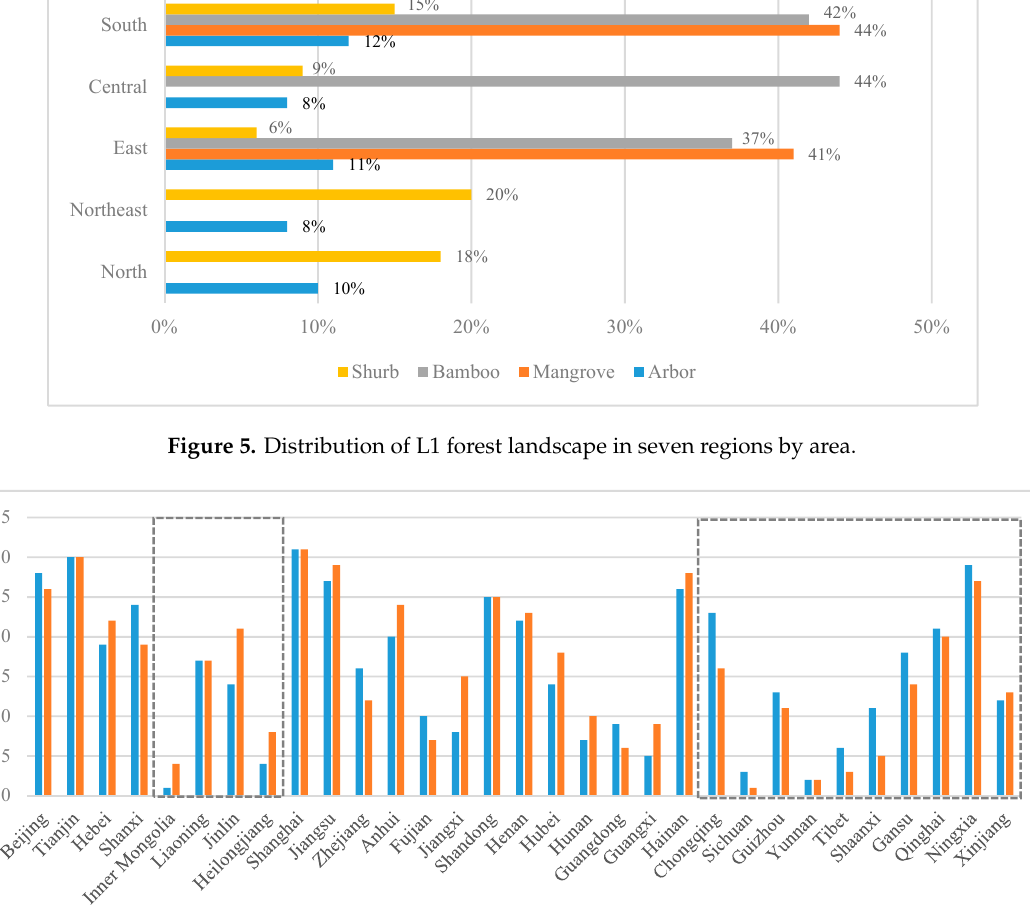
Figure 5. Distribution of L1 forest landscape in seven regions by area.